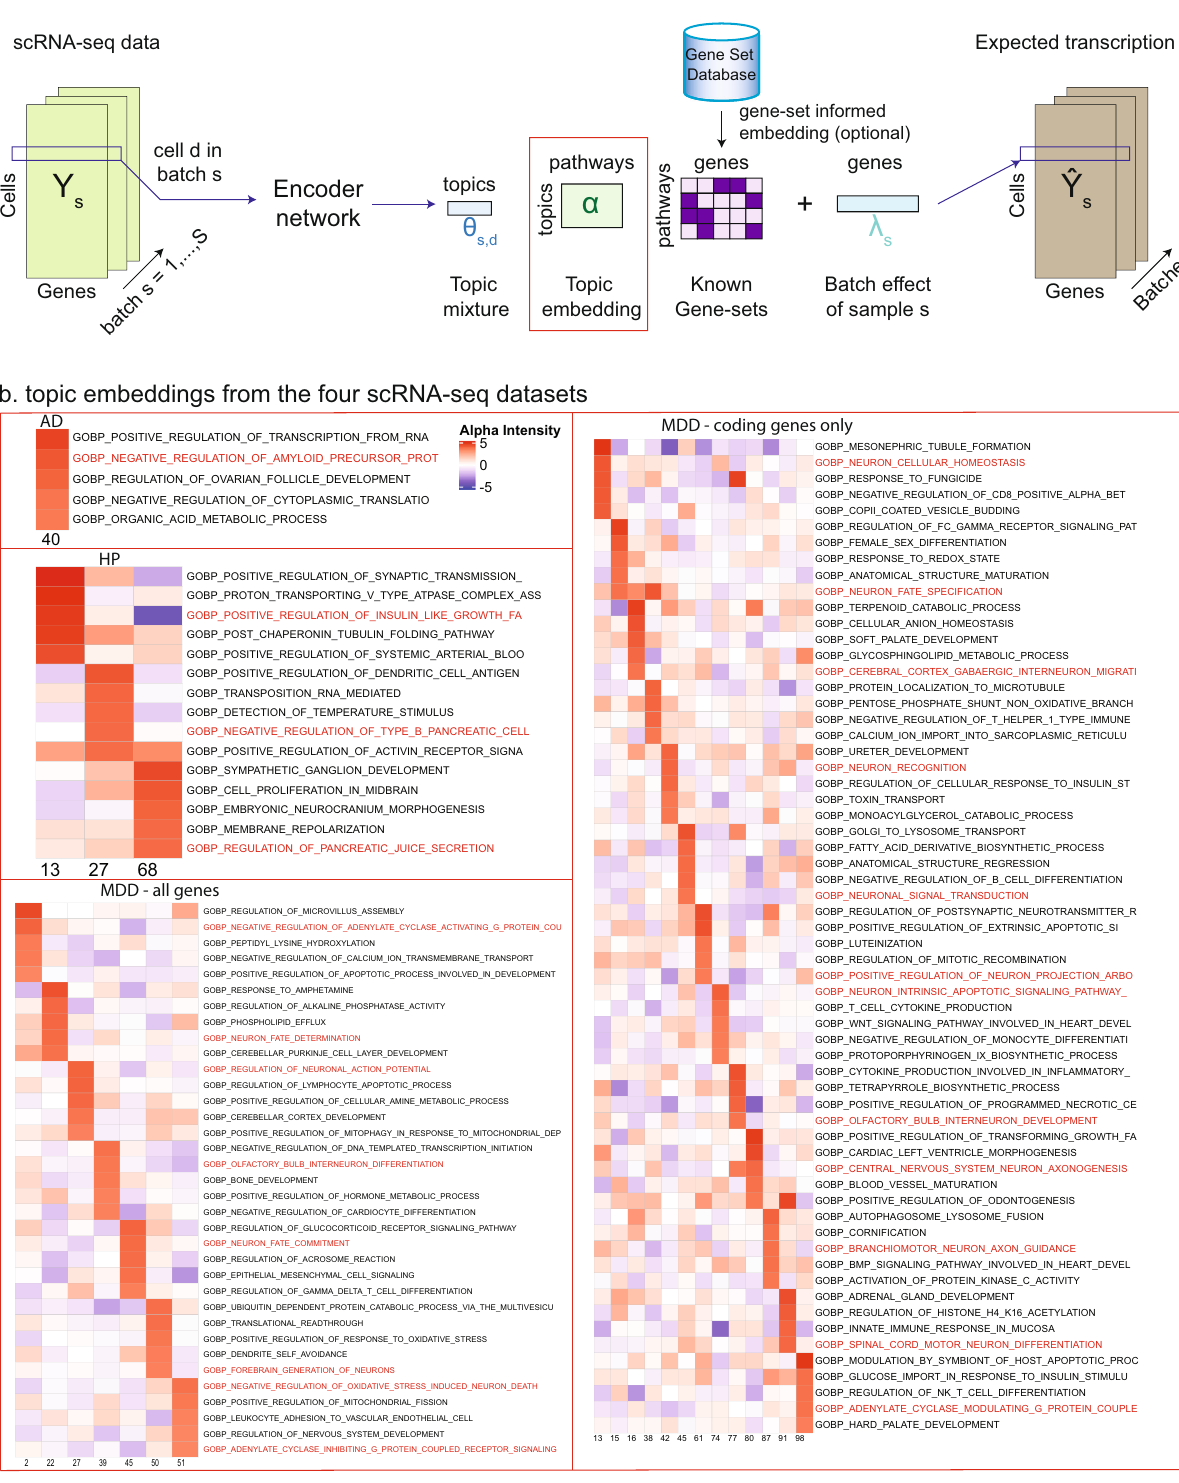
Fig. 7 Pathway-topics embeddings learned by the pathway-informed scETM (p-scETM). a p-scETM overview. Pathways information as pathways-by- genes are provided as the gene embedding in the linear decoder. The learned topic embedding is the direct association between the topics and pathways. b The pathway-topics heatmap of top 5 pathways in selected topics. Here, the pathways are the Gene Ontology-Biological Processes (GO-BP) terms. For the HP dataset, GO-BP terms whose names include the keywords insulin or pancreatic were highlighted. For the AD dataset, GO-BP terms whose names include the keywords amyloid or alzheimer were highlighted. For MDD — all genes and MDD — coding genes only, GO-BP terms whose names include the keywords neuron or G-protein were